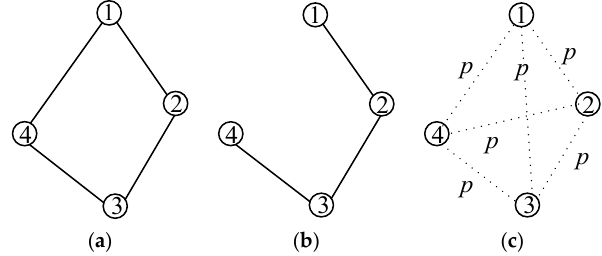
Figure 1. Different network models: ( a ) k nearest neighbor model; ( b ) disc model; ( c ) Erdos ‐ Renyi random graph.